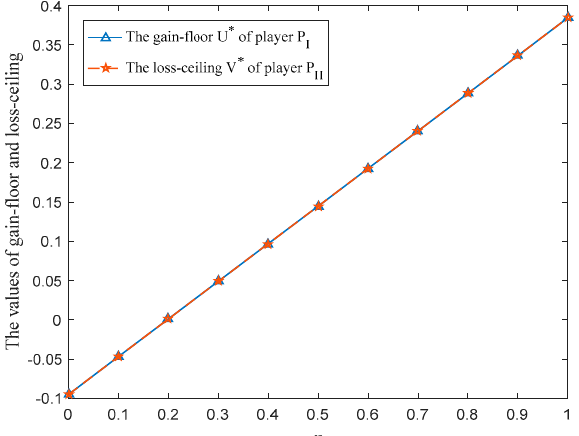
z with parameter η varying from 0 to 1. Figure 6. j